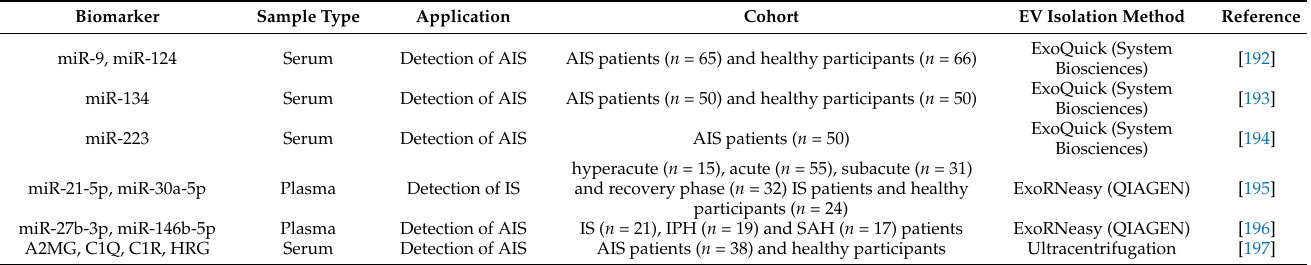
Table 2. EV cargo as biomarker candidates in